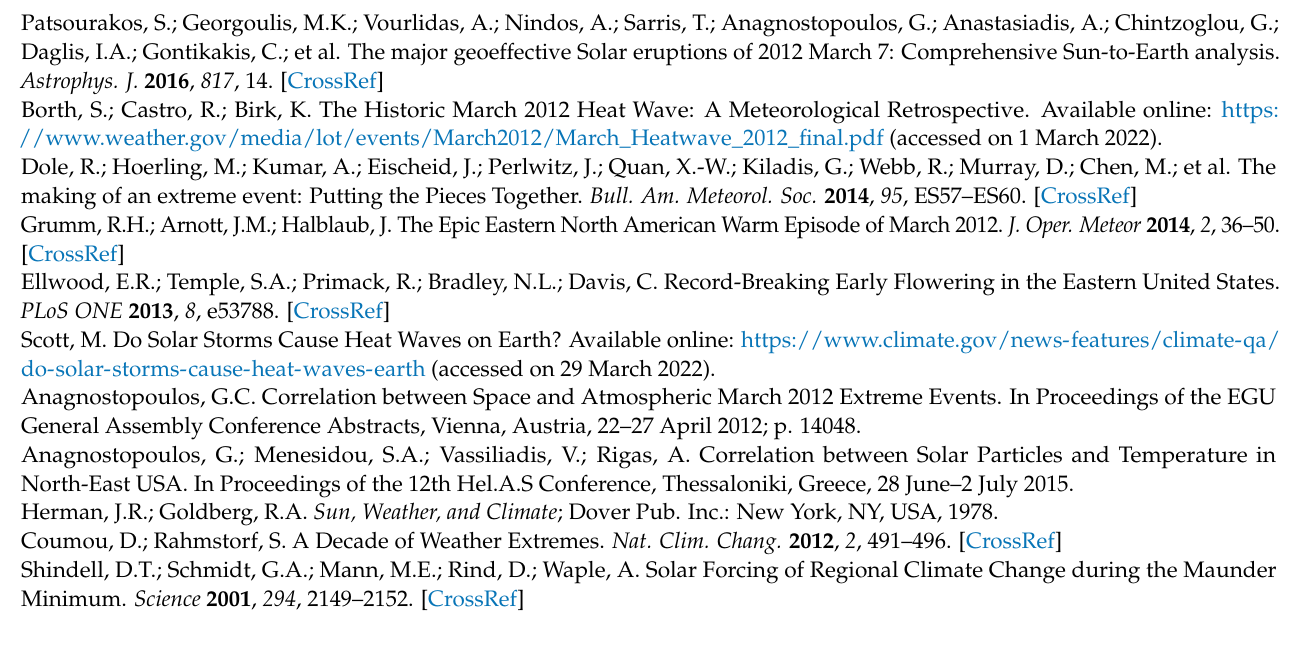
Table A1 shows the dates and the highest value of the Dst index of 28 storms between August 1997 and March 2015: the 27 magnetic storms were selected by using the selec- tion criterion Dst ≤ − 150 nT (the event #27 concerns our reference event of March 2012). Table A1 also provides information from high-energy protons from various instrumenta- tions as well as the temperature variation ∆ T M during times in Madison, Wisconsin, around the magnetic storms selected. In particular, Table A1 shows for each magnetic storm: its numbering (1st column), the correspond- the number of a Ground-Level Event (5th c.; if existing), the date of the possible associated 14 days from the SEP onset (7th c.), and the peak-to-background flux ratio of the associated SEP event as observed by ACE in the EPAM energy channel 1880–4700